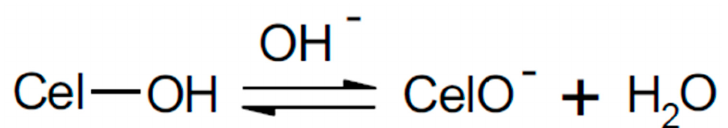
Figure 3. Formation of cellulosate anione. Reprinted by permission from the Springer Nature, Fibers and Polymers, The e ff ect of biodegradable organic acids on the improvement of cotton ink-jet printing and antibacterial activity, Soleimani-Gorgani, A., Karami, Z. Copyright (2017)